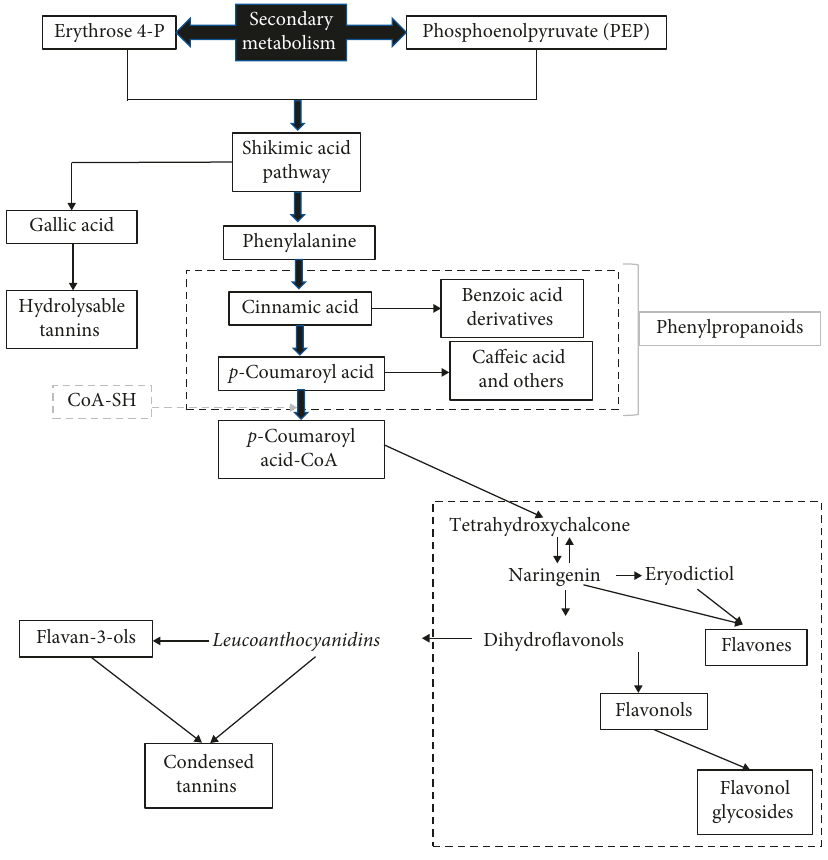
Figure 1: Biosynthesis of polyphenols in Buddleja scordioides